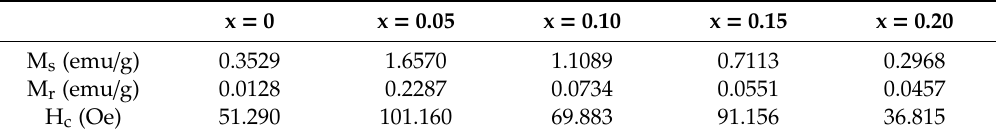
Figure 11. M-H hysteresis loops for Bi 1 − x Eu x FeO 3 powders: Inset showing the low-field M = f(H) dependence. Table 5. M s , M r and H c for Bi 1 − x Eu x FeO 3 powders.